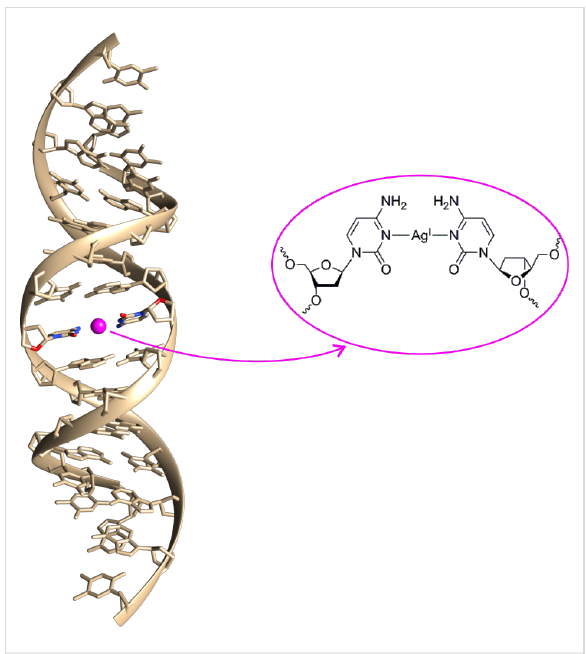
Figure 1: Structure of a B-DNA duplex comprising a central C–Ag(I)–C base pair. This figure was created based on the coordinates reported in PDB entry 2RVP